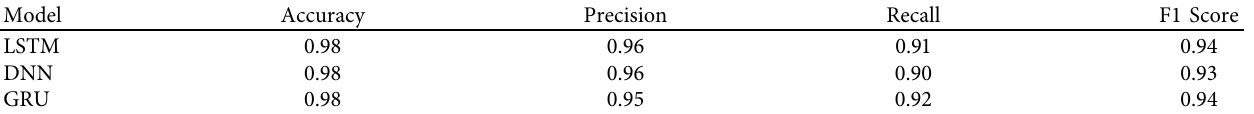
Table 15: Performance results for deep learning models.